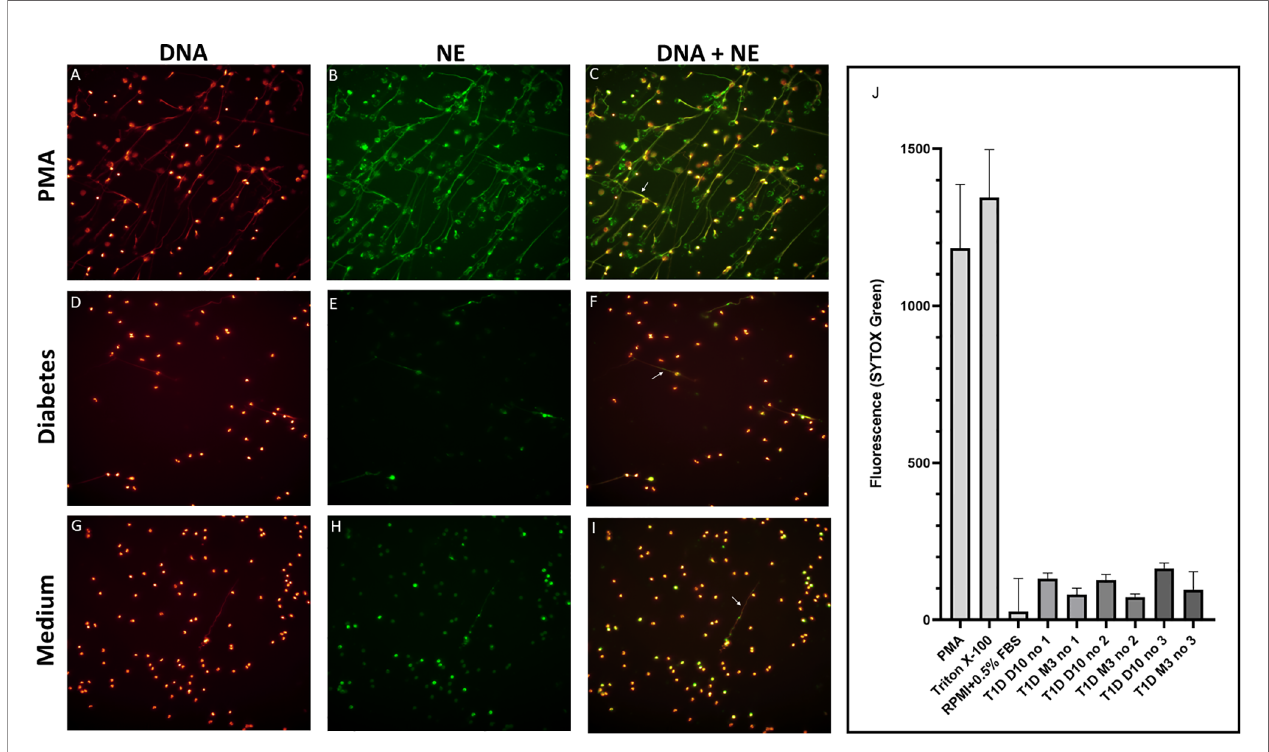
FIGURE 2 | Visualization and quanti fi cation of NETs. Neutrophils were isolated and cultured for 4h at 37°C with or without 20 nM PMA or with 5% serum from T1D children. NETs were visualized by immuno fl uorescence microscopy using a 25× objective and de fi ned as extracellular co-localisation of DNA and neutrophil elastase (NE). DNA was labelled with DAPI (glow, red) and NE with an Alexa Fluor 488 – conjugated antibody (green). Neutrophils from a healthy control were either stimulated with (A – C) PMA, (D – F) serum from a diabetes patient (day 10 in the illustration) or (G – I) left unstimulated. Arrows in the merged images indicate NETs (C, F, I) . (A – I) in this fi gure is not intended for quanti fi cation of NETs but selected to demonstrate that neutrophils can produce NETs when stimulated with serum from diabetes patients. Quanti fi cation of NETs using Sytox Green is shown in (J) . PMA, Triton X-100 and medium (RPMI + 0.5% FBS) were used as controls. Serum from three T1D patients 10 days and 3 months after diagnosis were used to induce NETs. NETs, neutrophil extracellular traps; PMA, phorbol-12-myristate-13-acetate; FBS, fetal bovine serum.